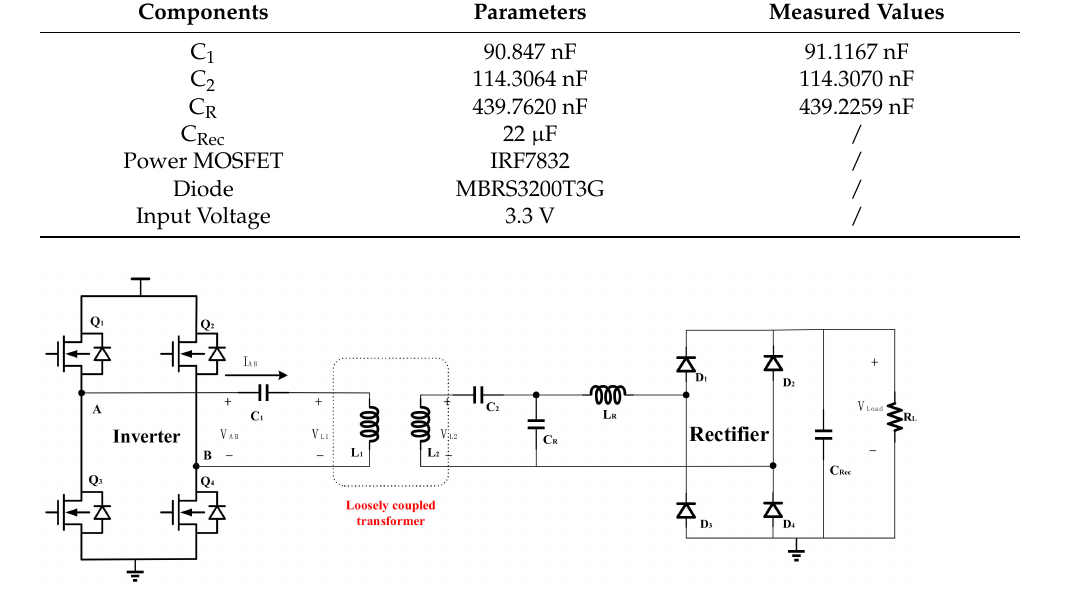
Figure 32. S/LCC compensation topology in IPT